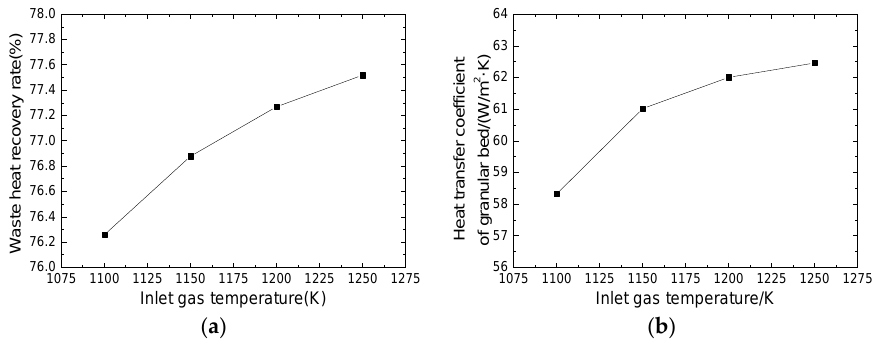
Figure 8. Influence of flue gas temperature on the heat transfer in granular bed. ( a ) Influence on the waste heat recovery rate. ( b ) Influence on the heat transfer coefficient.